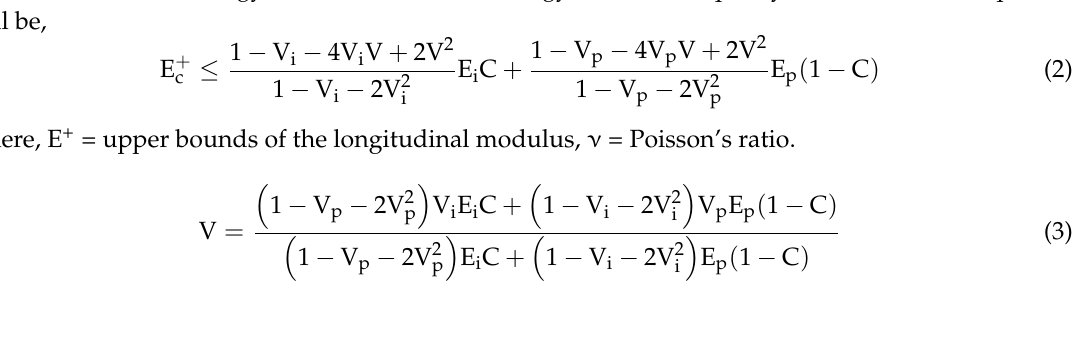
Figure 4. Representative stress-strain curves ( a ) neat CA ( b ) 0.5% CA-MWCNT ( c ) 1.0% CA-MWCNT ( d ) 1.5% CA-MWCNT ( e ) 2.0%